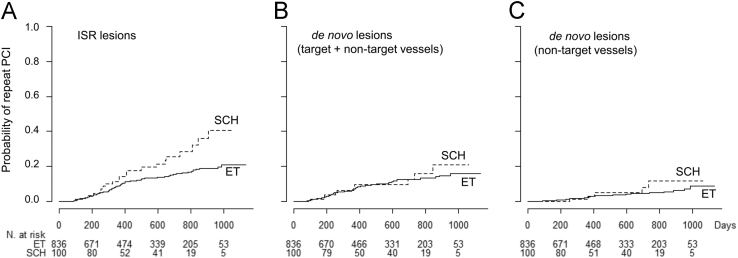
Probabilities of repeat PCIs for ISR lesions (A), de novo lesions (B) and non-target vessel de novo lesions (C).Repeat PCIs for ISR lesions (A) were more frequently performed in the SCH group than in the ET group, whereas the frequencies of repeat PCIs for de novo lesions overall (B) and in non-target vessels (C) were not different between the two groups.PCI, percutaneous coronary intervention; ISR, in-stent restenosis; SCH, subclinical hypothyroidism; ET, euthyroidism.